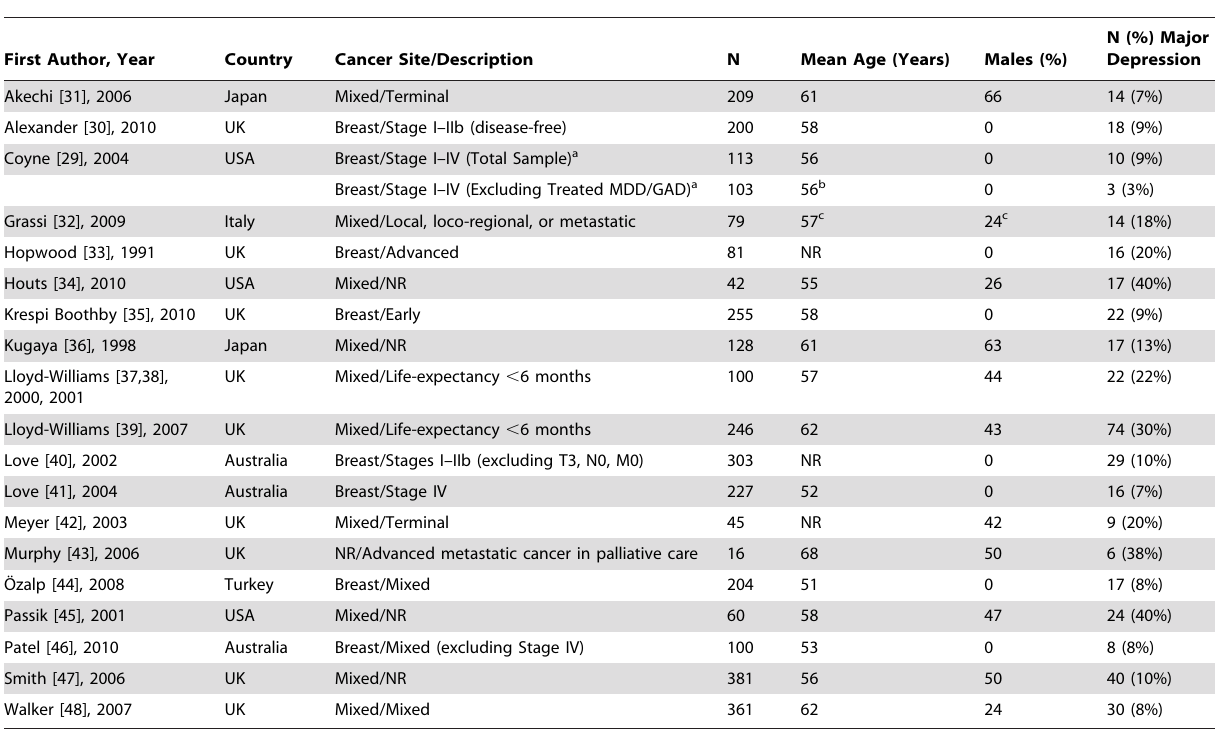
Table 1. Patient Characteristics in Studies of Diagnostic Accuracy of Depression Screening